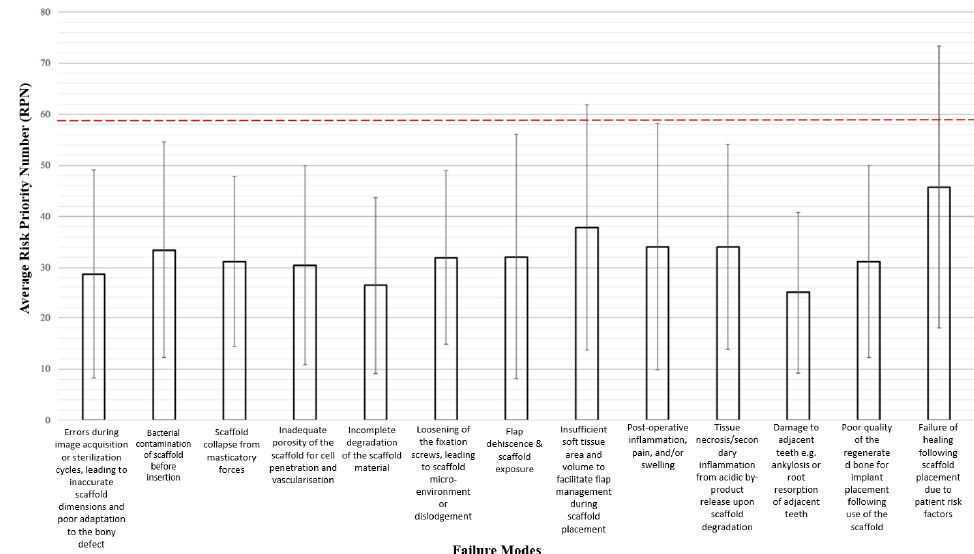
Figure 4. Mean RPNs of all 13 failure modes assess. Red dotted line indicates the threshold of risk priority number (RPN) at 59. priority number (RPN) at